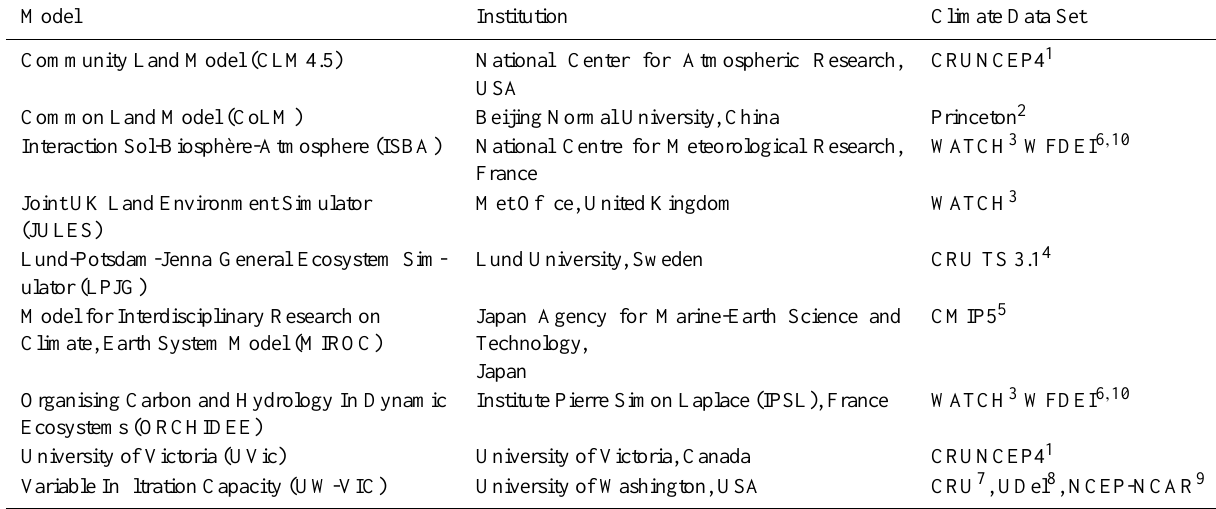
Table 1. Models participating in the Vulnerability of Permafrost Carbon Research Coordination Network (RCN) retrospective simulations. Modeling groups provided outputs for year 1960–2009, with the exception of CLM (–2005); JULES (–1999); UW-VIC (–2006).